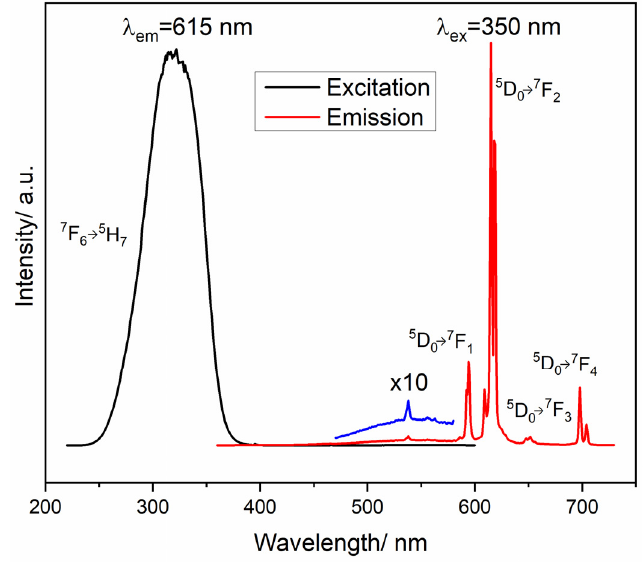
Figure 6. Excitation and emission spectra of LuVO 4 films with 2.5 at. % Eu 3+ and 1.5 at. % Bi 3+ after 3 h of annealing at 1000 °C.